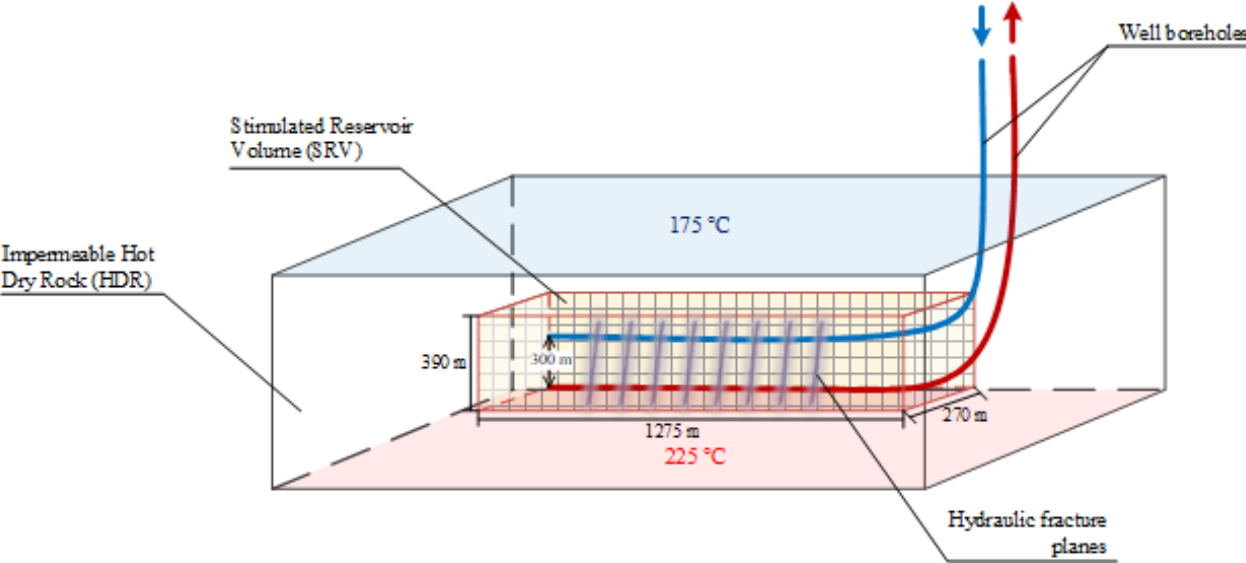
Figure 4. Conceptual simulation model with highlighted well boreholes, SRV region, and hy- draulic